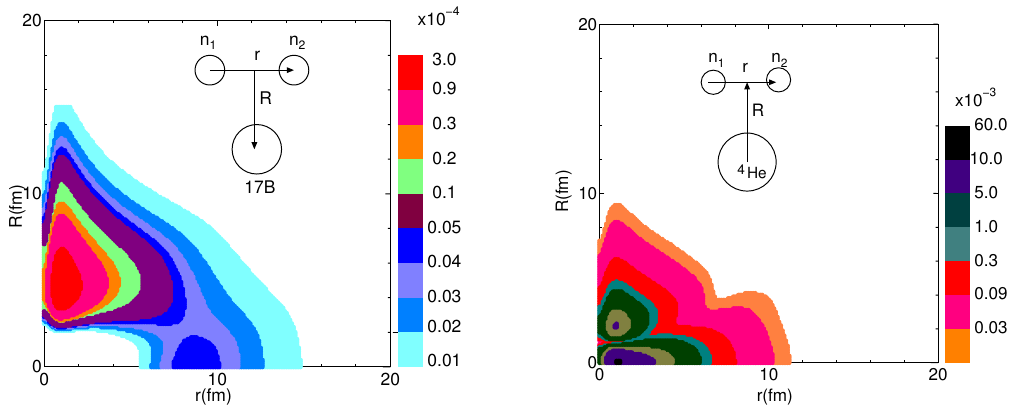
Figure 8: Ground-state probability amplitude | Ψ ( r , R ) | 2 as a function of the Jacobi = − 100 fm in model version (ii) and right panel coordinates: left panel 19 B for a S for the similar structure 6 He [ 32,33 ]